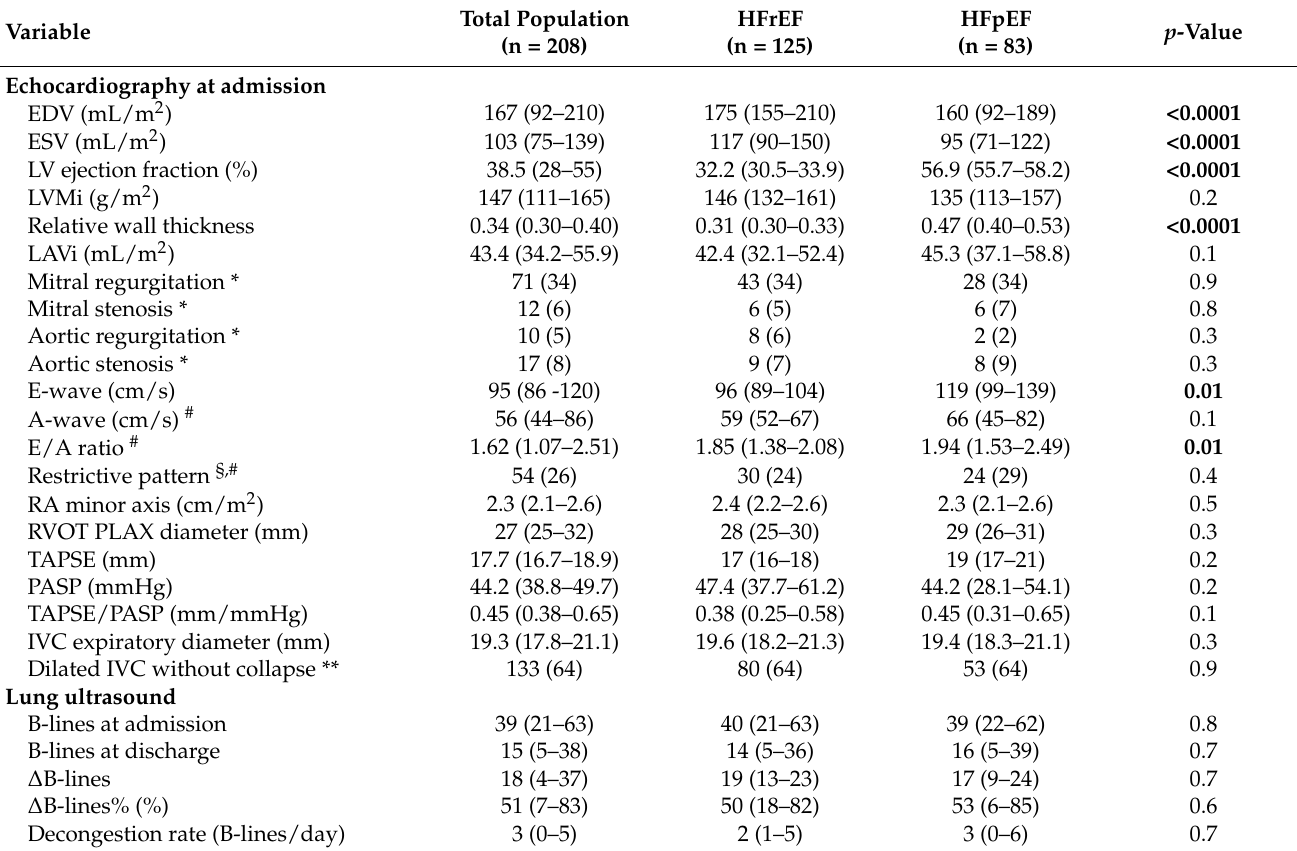
Table 2. The ultrasound parameters in the overall population and by left ventricle ejection